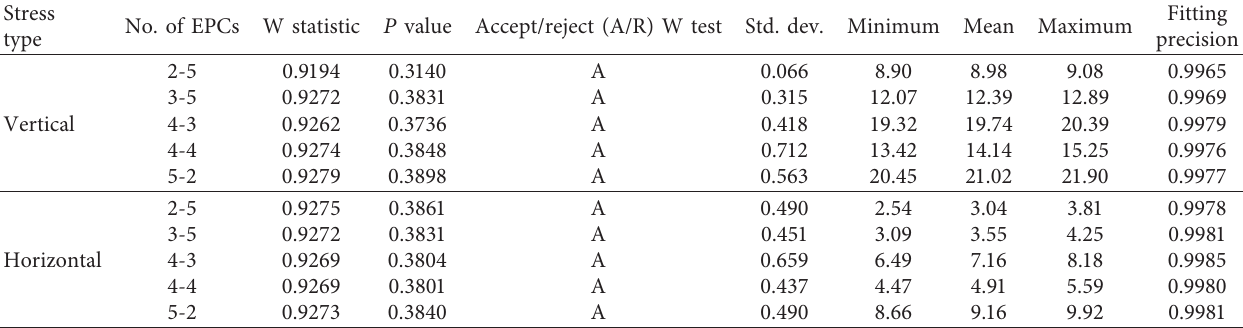
Table 4: Reliability verification of measured stresses in the free zone. Stress